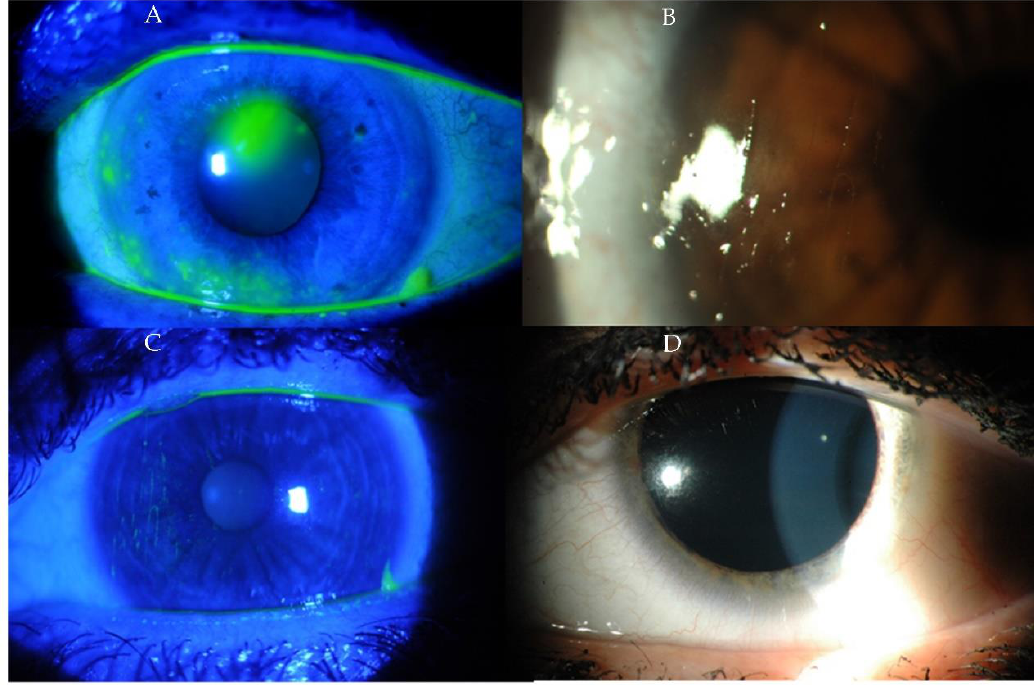
Figure 2. ( A – D ) Photographs of the anterior segment of the eye of patients with corneal filaments and mucus deposits—advanced dry eye syndrome.